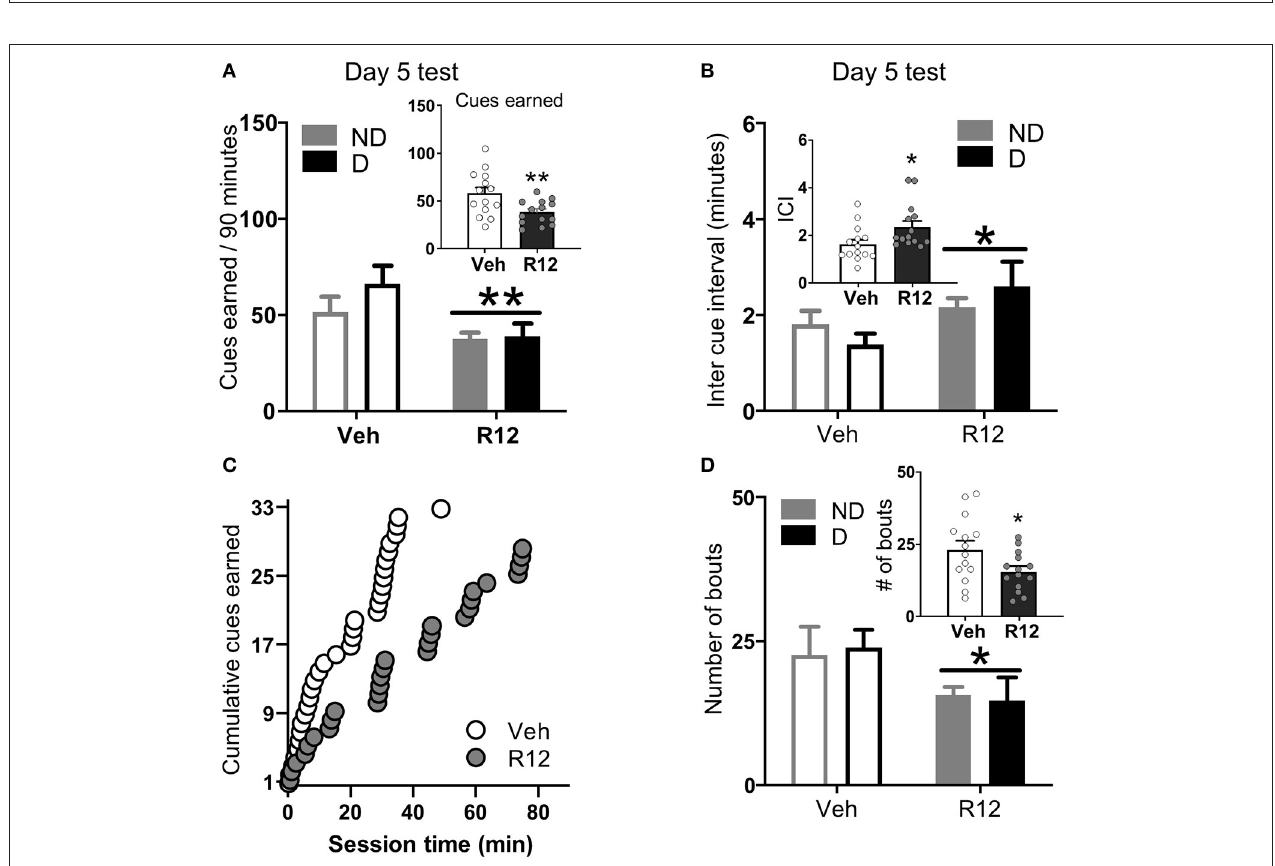
FIGURE 2 | earned across the 15 3h self-administration sessions, sessions 1–5: before dependence and no infusion maximum criteria, 6–15: during dependence with infusion maximum criteria. (E) Latency to reach infusion maximum criteria in minutes. (F) Active/Inactive Lever pressing for dependent and non-dependent rats during training. (G) Active Lever press rate. * p < 0.05, main effect of dependence, *** p < 0.001, different from non-dependent. SA, Self-administration; ND, non-dependent; D, dependent. Data are mean ± SEM.